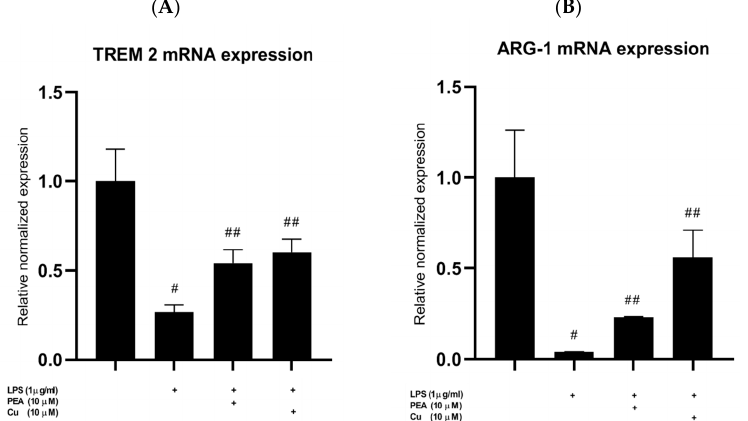
Figure 2. Real Time-PCR was performed to measure the mRNA expression of neuroprotective or anti-inflammatory markers after 24 h treatment. BV2 cells were pretreated with the indicated concentrations of PEA and curcumin (Cu) followed by treatment with LPS (1 µ g/mL for 24 h). Data are shown as the mean ± SD of three independent experiments. # p value < 0.05 compared with control group. ## p < 0.05 compared with LPS group.